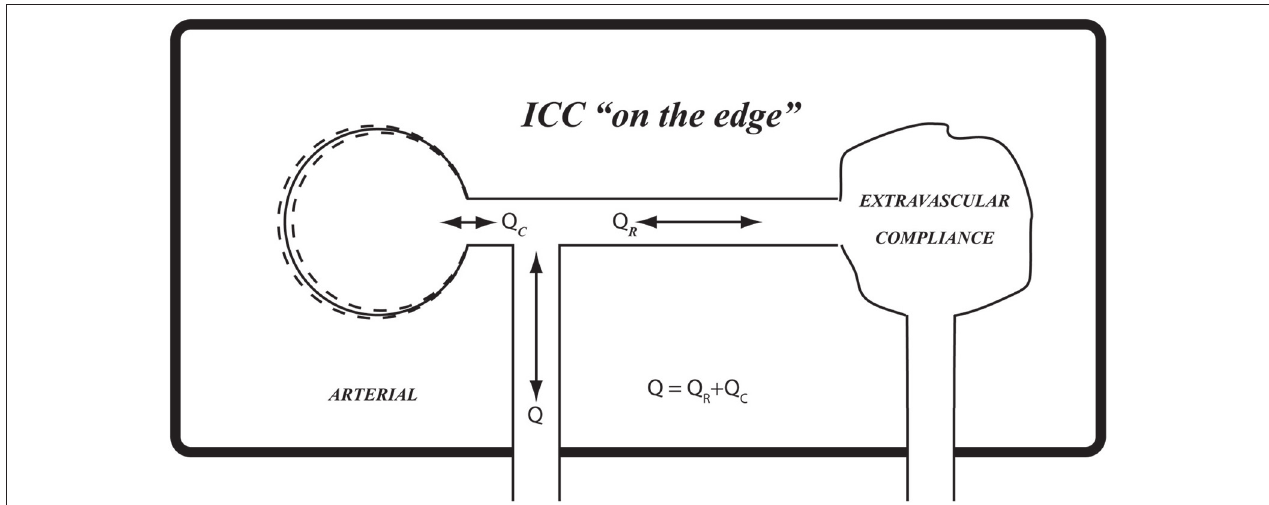
FIGURE 10 | The results in Figures 6 , 7 suggest that the prevailing compliance for pulsatile blood flow within the confines of the rigid skull ( ICC ) is at a critical value which we have termed “on the edge.” Using the balloon analogy, it can be likened to a balloon that is inflated to a critical volume whereby it provides extravascular compliance if inflated any further and no compliance if it is deflated any